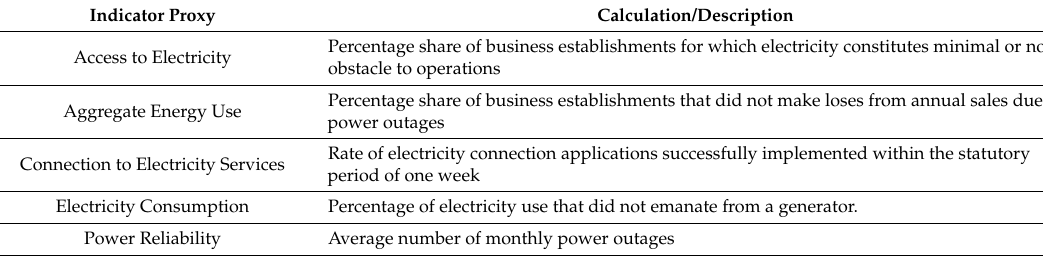
Table 3. Proxy Indicators for Power.